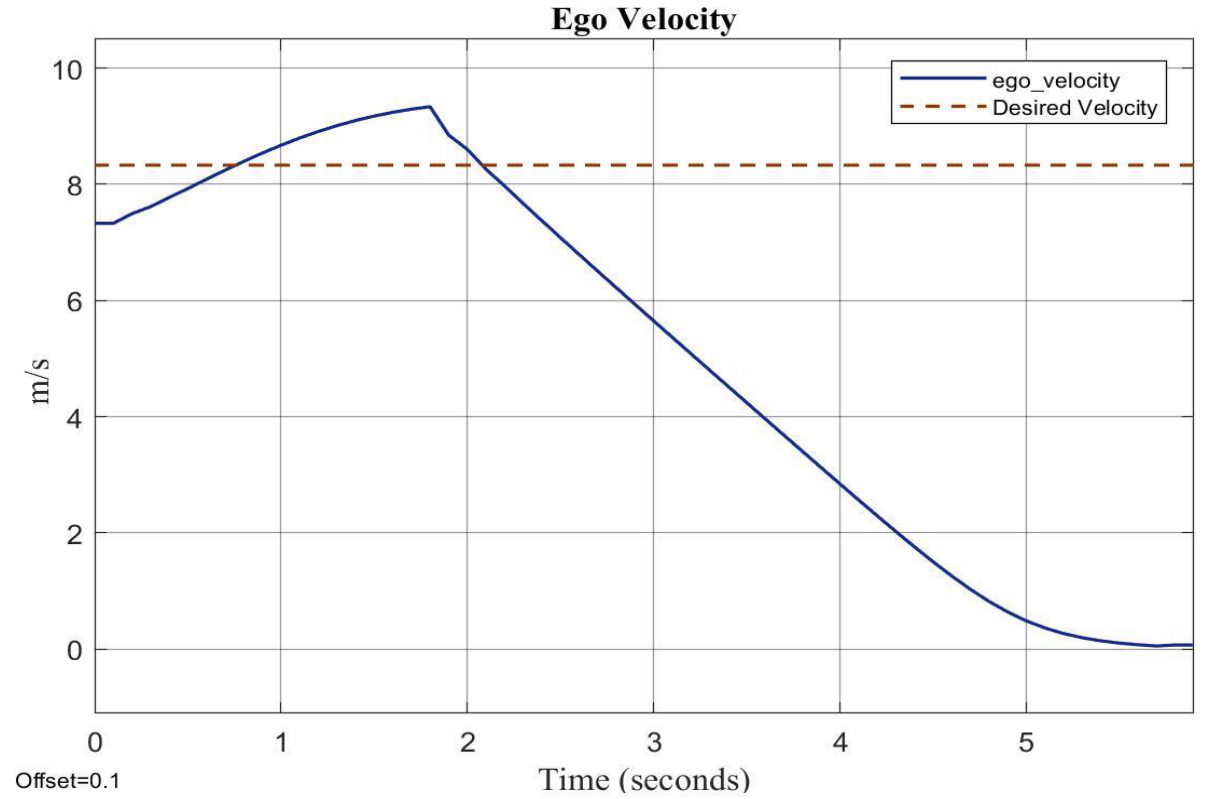
Figure 21. Speed graph of previous PI-based controller.